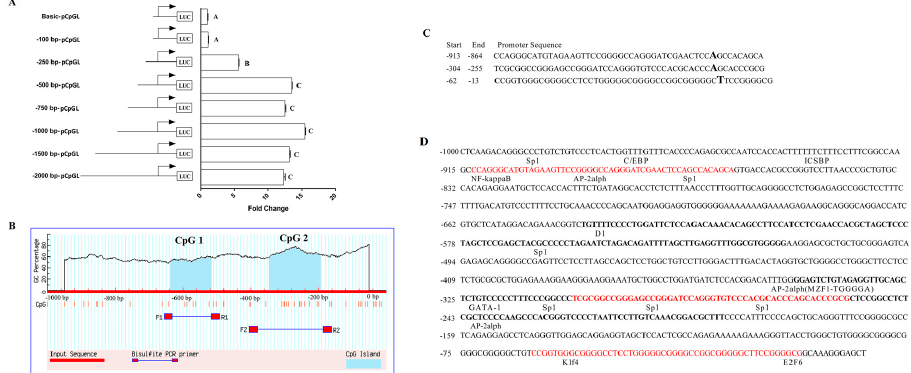
Figure6. Activityverificationof TLR5 promoterregionandpredictionofCpGislandandactingelements. ( A ) Detection of dual luciferase activity in di ff erent regions of the TLR5 promoter region. Luciferase Figure 6. Activity verification of TLR5 promoter region and prediction of CpG island and acting activity was calculated as the ratio between firefly luciferase activity (Rn) and perineurin luciferase elements. ( A ) Detection of dual luciferase activity in different regions of the TLR5 promoter region. activity (Ff). The abscissa represents fold-change in the luciferase activity of the promoter region compared to the control plasmid (Basic-pCpGL). The ordinate represents the plasmid corresponding to the di ff erent truncated segments. Di ff erent capital letters indicate significant di ff erences ( p < 0.01). ( B ) CpG island prediction at 1000 bp upstream of the transcription start site. ( C ) Prediction of the core promoter region based on BDGP software. ( D ) Analysis of acting elements in the promoter region. The red letters represent the core promoter region, bold letters represent CpG island sequences, and underlined letters represent the binding sites of acting